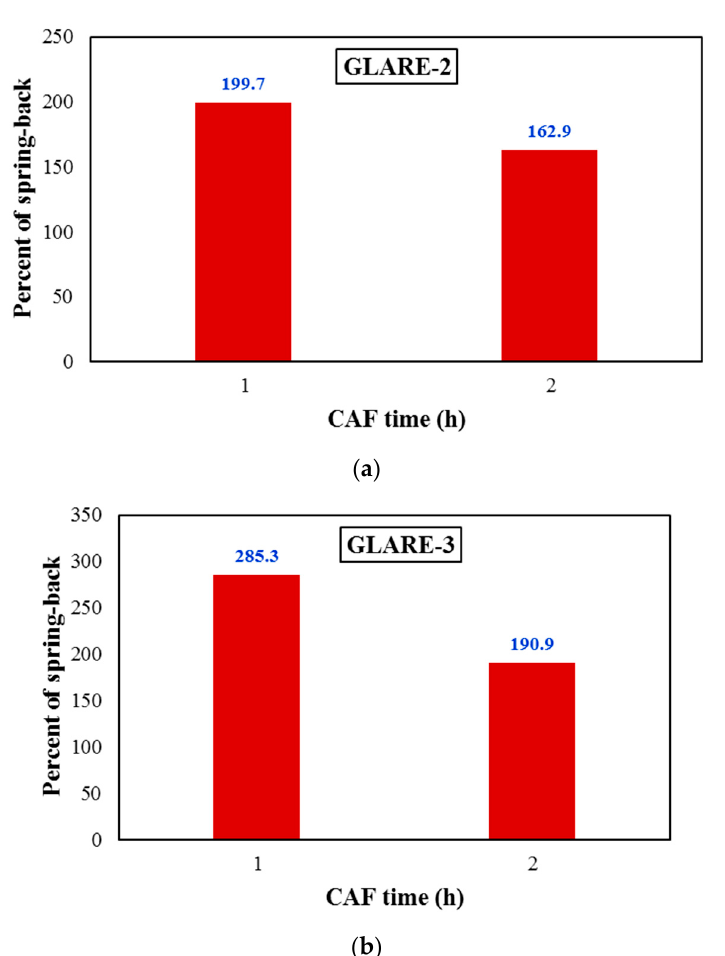
Figure 6. Effect of thickness of composites layer on the springback behavior of GLARE FMLs at CAF time 4 h and temperature 160 °C.